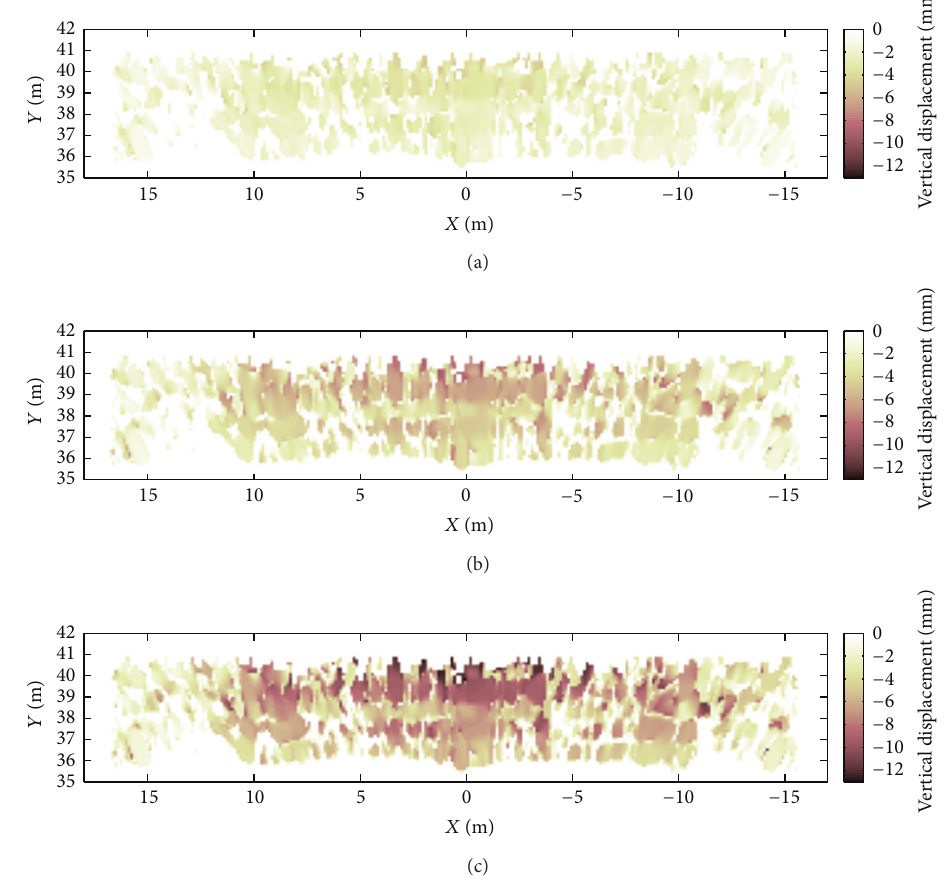
Figure 16: Displacement maps: (a) 2 trucks; (b) 4 trucks; and (c) 8